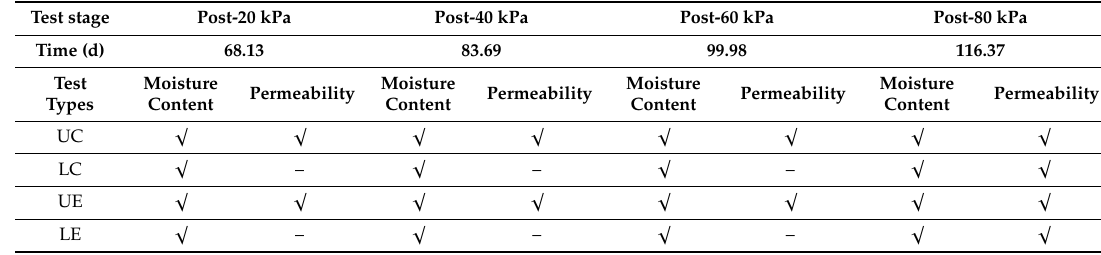
Table 3. Soil sampling and testing